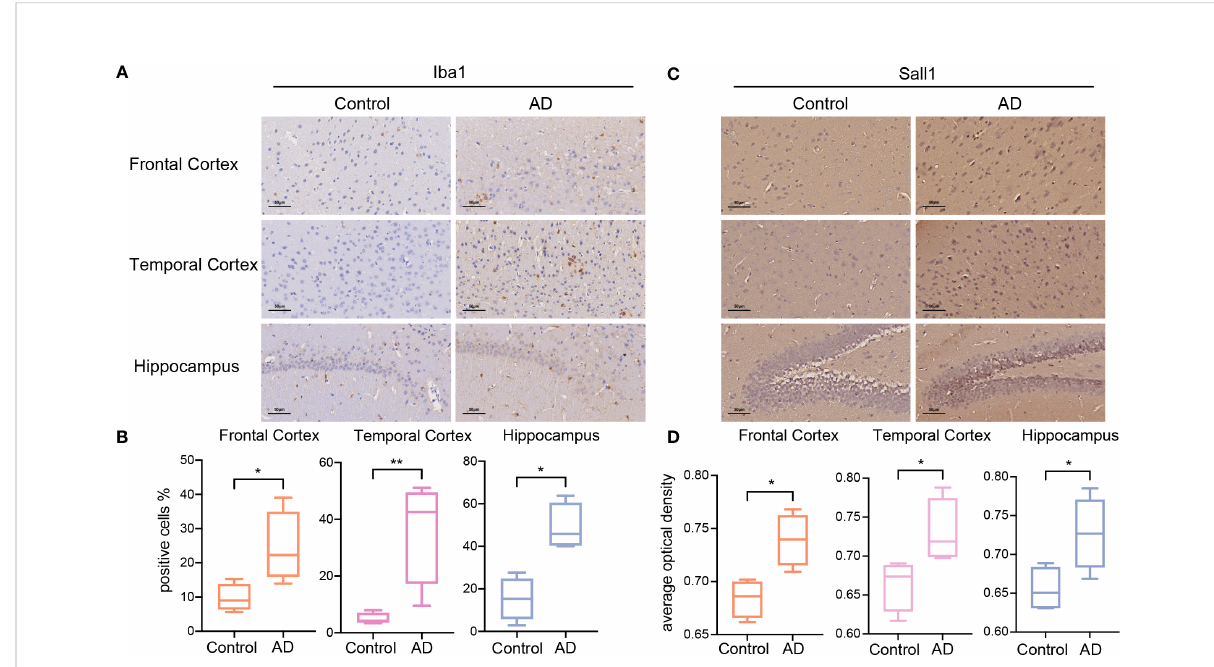
FIGURE 5 The expression of Iba1 and Sall1 in C57BL/6J mice and APP/PS1 AD model mice (A, C) IHC staining for Iba1 and Sall1 in different regions between the control and AD samples. (B, D) The expression levels of Iba1 and Sall1 in different regions between the control and AD samples, n=4. *p<0.05, **p<0.01. AD, Alzheimer ’ s disease; SALL1, Spalt Like Transcription Factor 1; and Iba1, ionized calcium-binding adapter molecule